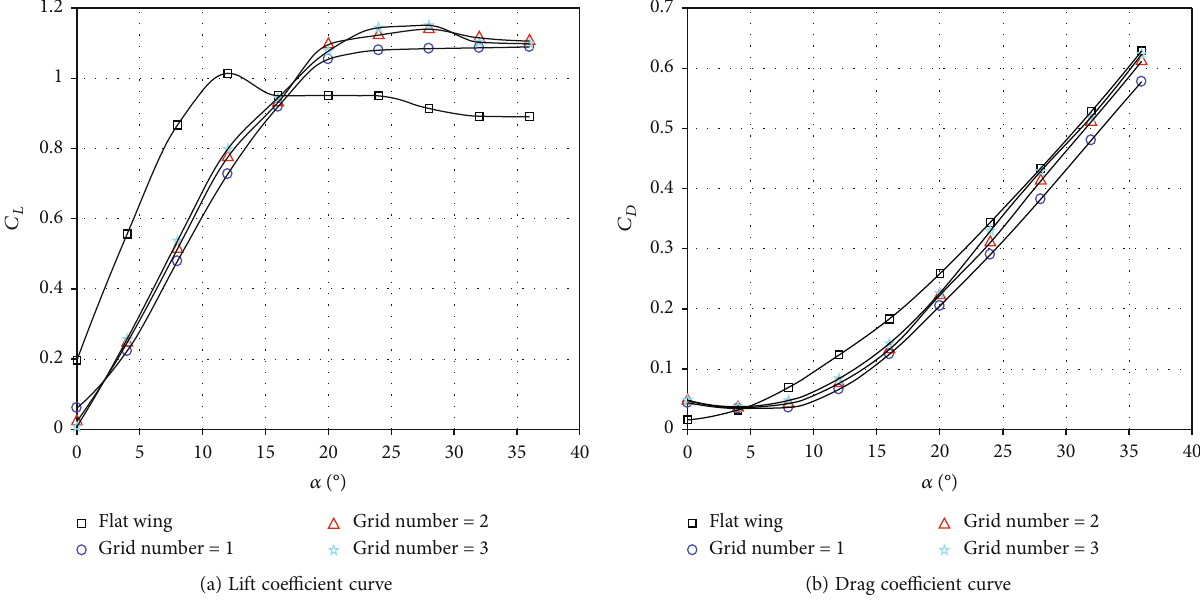
Figure 21: The lift coe ffi cient and drag coe ffi cient curves of the grid fusion lifting surface with di ff erent grid numbers ( Ma = 0 : 6